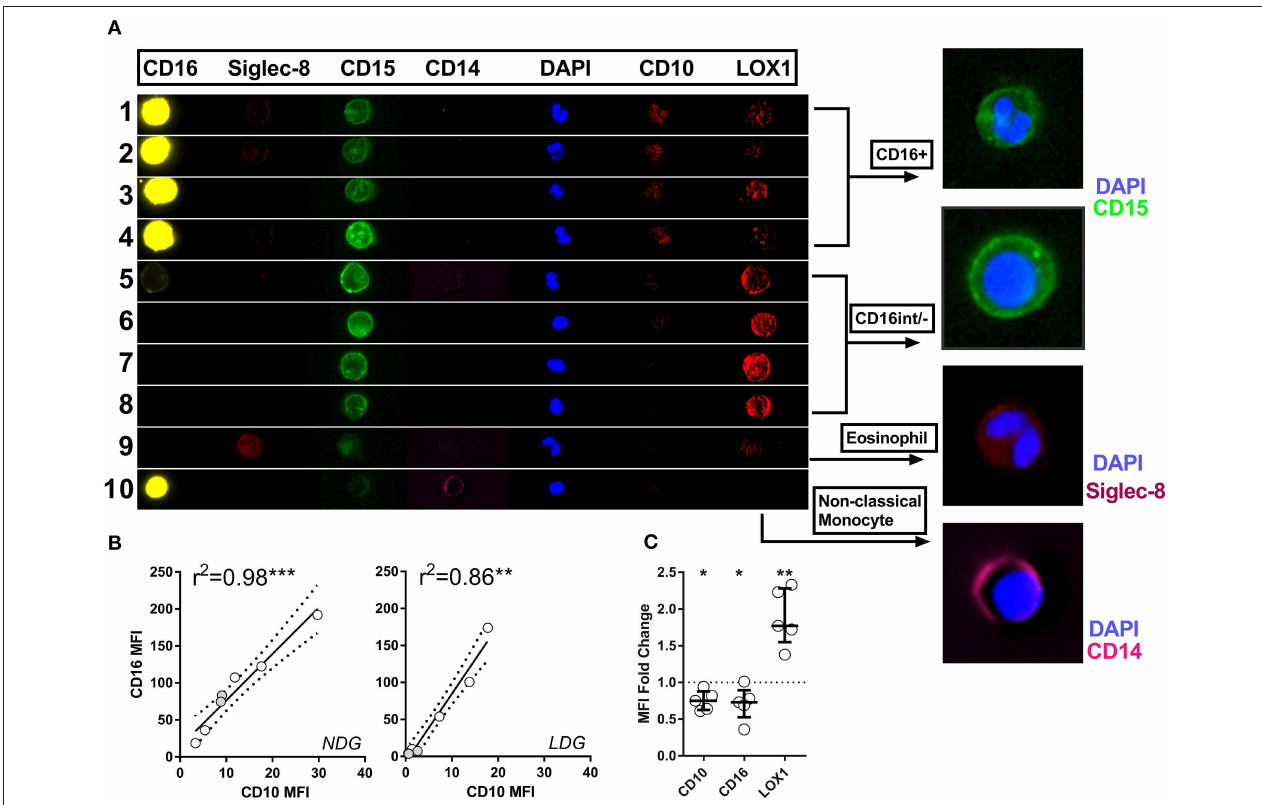
FIGURE 5 | Imaging flow cytometry allows definitive phenotyping of PBMC cell populations. Representative images are shown of various cell populations from a patient with active AAV, with each row illustrating the separate channels, alongside merged images (A) . Rows 1–4 show CD15 + CD16 + granulocytes, rows 5–8 CD16 int / − granulocytes, row 9 eosinophil and row 10 monocyte. CD10 expression correlates closely with CD16 expression in both LDGs and NDGs. Spearman correlation (B) . Differential CD10, CD16 and LOX-1 expression between LDG and NDG was then assessed by analyzing the fold change in MFI between the